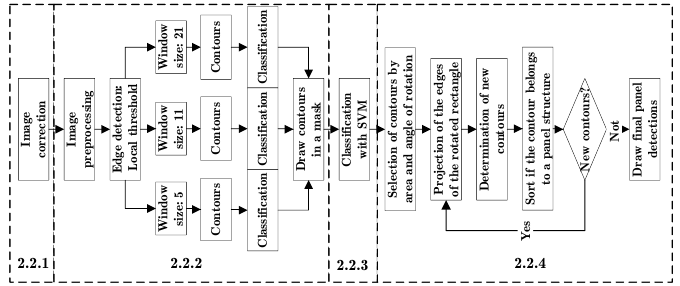
Figure 2. Method based on classical techniques and the numbers of the sections where the algorithm is